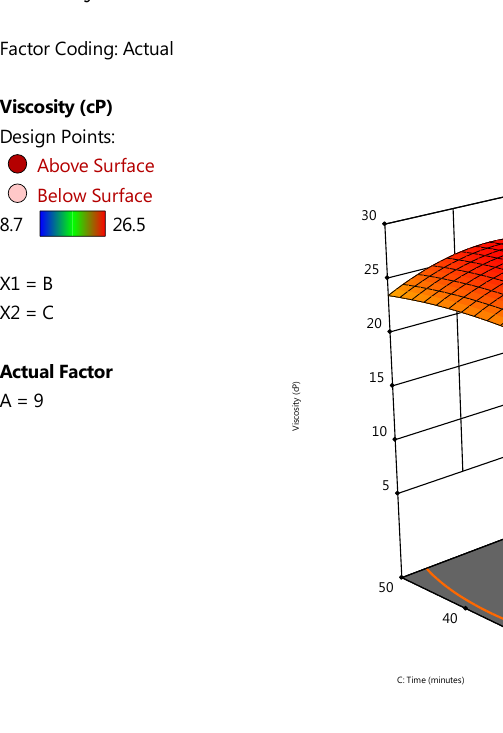
Figure 9. Effect of time and temperature on viscosity of